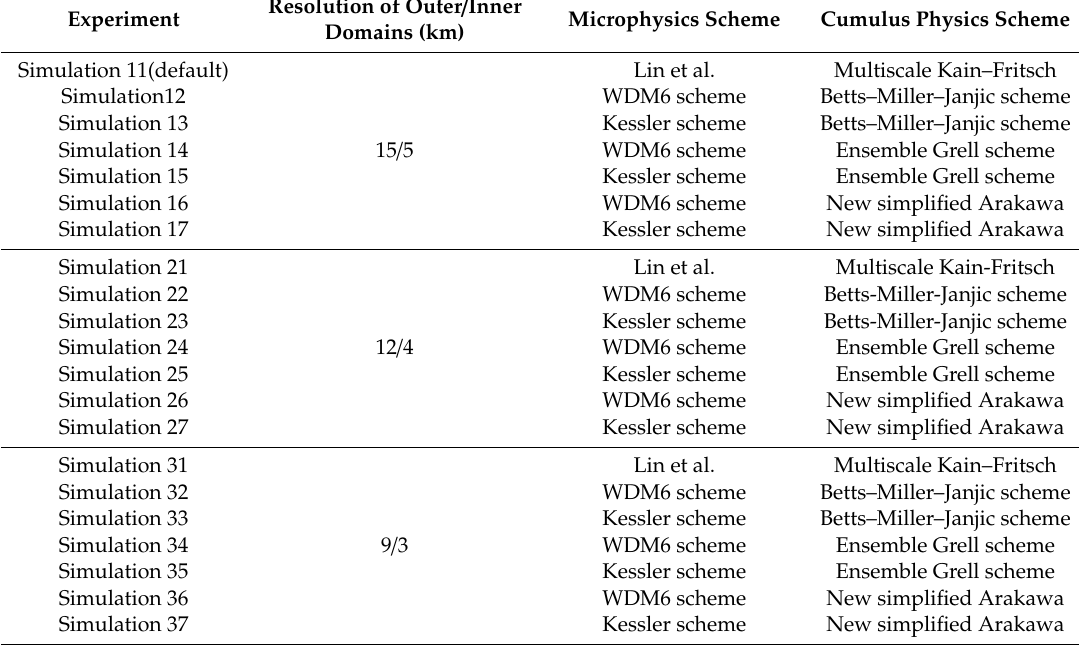
Table 2. Experimental summary of sensitivity studies for resolution, microphysics, and cumulus physics. The configuration of simulation 11 is the same as that of the default model seen in Table